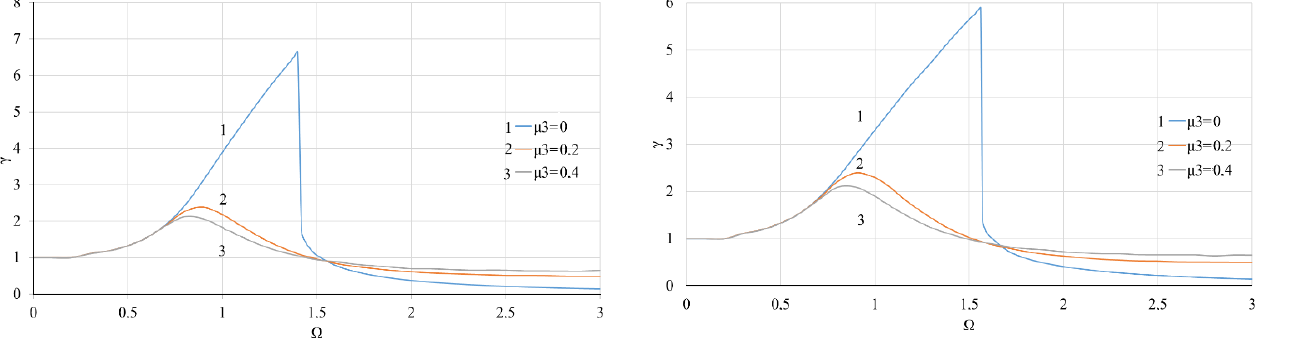
Figure 13. Dependence of the moment of force transmissibility of the system γ on the rotor velocity (cid:127) with nonlinear stiffness coef- ficient of the support K 3 = 0 . 1 at value of the coefficient of linear viscous damping µ 1 = 0 . 1 and various values of nonlinear viscous damping coefficient µ 3 .